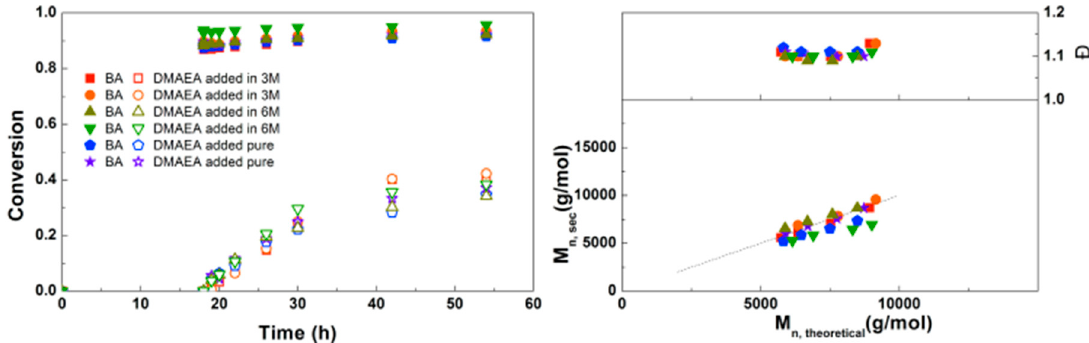
Figure 5. ( Left ): conversion versus time plot for Cu(0)-mediated one-pot block copolymerization of BA and DMAEA using [BA]:[DMAEA]:[ECP]:[Me 6 TREN]:[CuCl 2 ] = 50:50:1:0.15:0.1, 3.0 M in DMF at 25 °C and 12.5 mm 2 /mL Cu(0) wire. A 3.0 M or 6.0 M solution of DMAEA in DMF or pure DMAEA was added after 18 h reaction time. ( Right ): corresponding molecular weight and dispersity versus theoretical molecular weight plot.